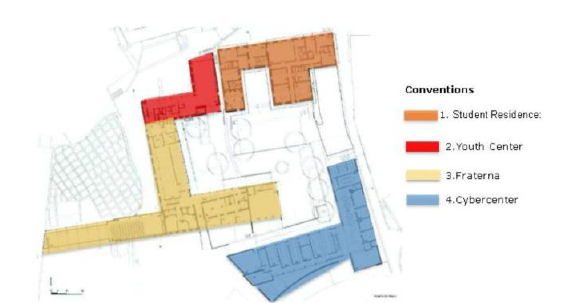
Figure 8. Architectural plans, first floor plan Area: 3 679 m². 4 levels, Year of Realization: 2001/2003, FDO - Construções, After, Multifunctional Couros Complex. Source: Revista Arquitectura & Vida 01-02-2007, P, 36.